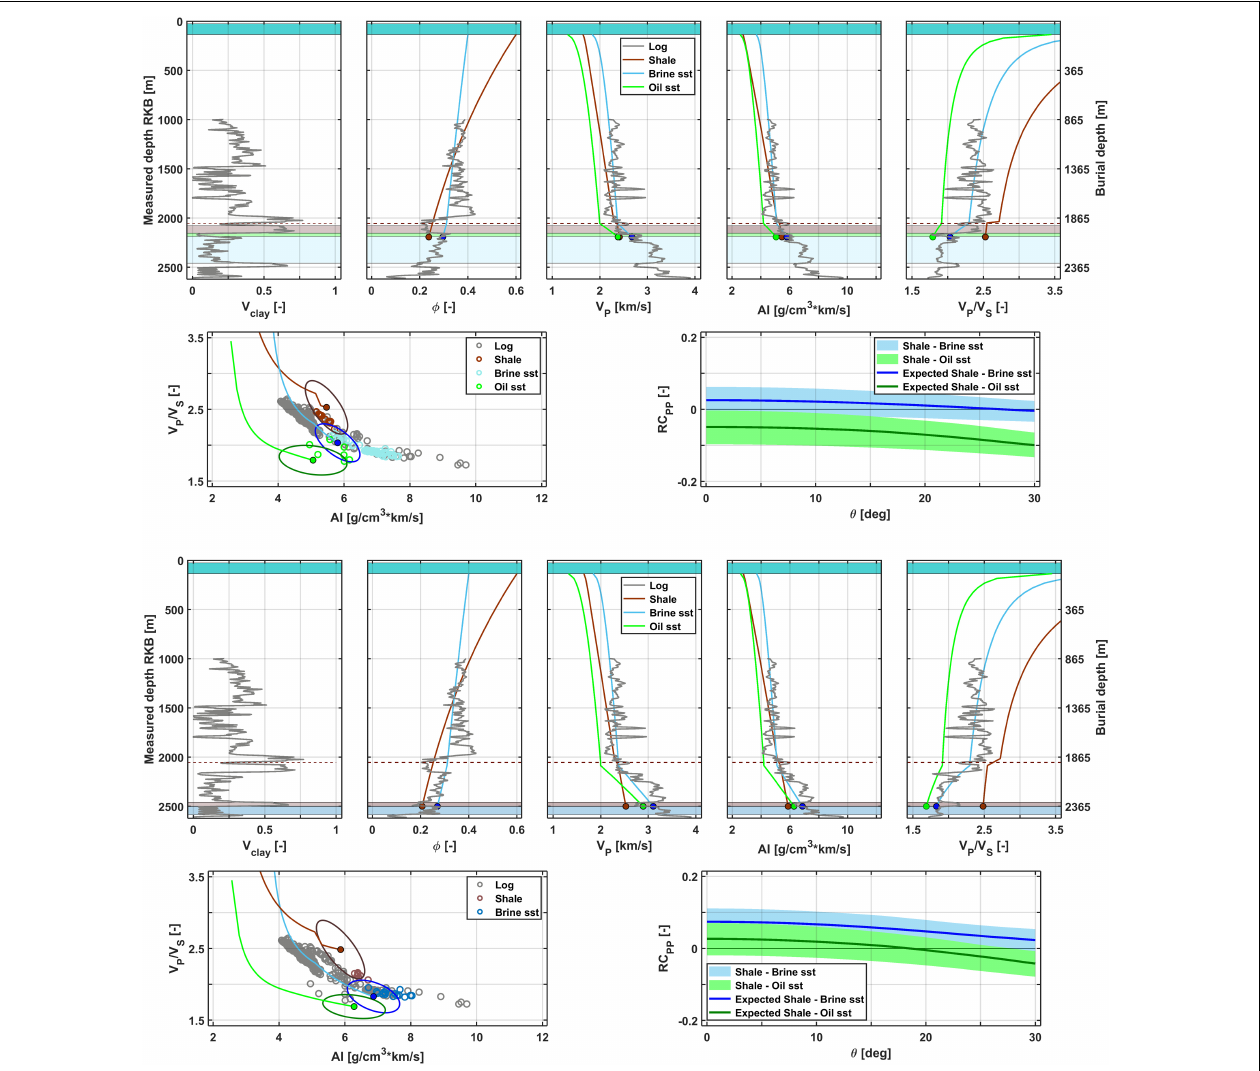
FIGURE 5 | Combined burial and rock physics modeling for Paleocene sandstones in Well 15/5-5 in the Glitne Field, North Sea. Note the change in elastic properties as we go from mechanical to chemical compaction at around 2,000 m burial depth (indicated by dashed brown horizontal line). The expected AVO signatures change drastically as we go from the Top Heimdal Fm horizon (upper) to the slightly deeper Top Ty Fm horizon (lower) . The expected oil response for the Ty Formation is similar to the expected brine response of the Heimdal Formation. This shows the importance of burial history as a key constraint in AVO analysis.